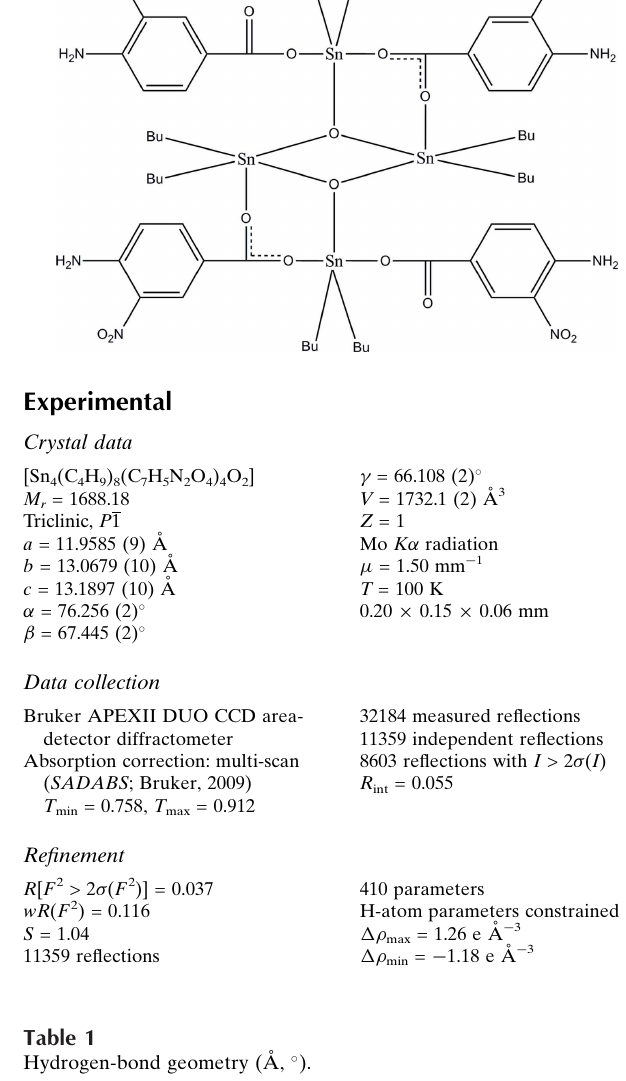
Hydrogen-bond geometry (A˚ , (cid:3)